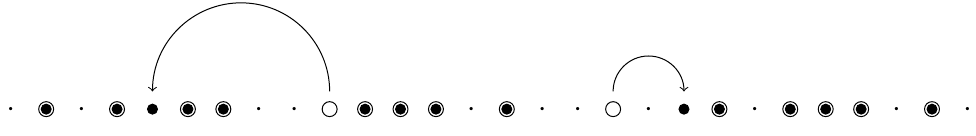
Figure 2: Sketch of a two particle-hole excitation: position of the momenta of the representative state (empty circles) and the intermediate state (filled circles) respec- tively, and position of the holes